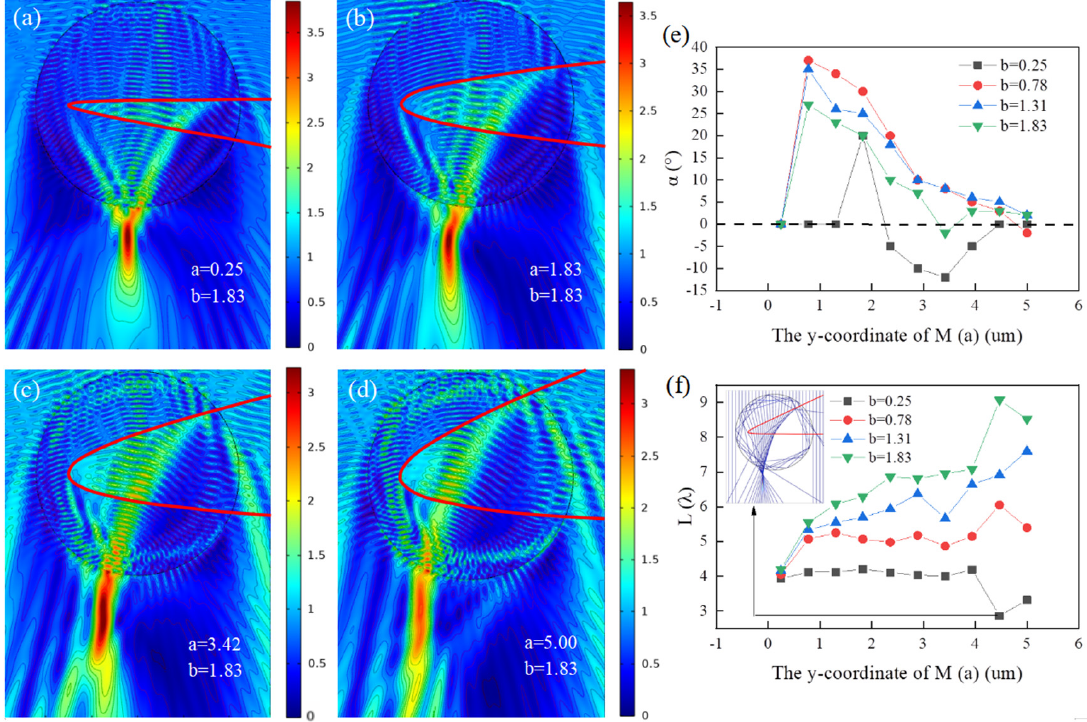
Figure 3. Distribution of electric field under plane wave illumination and the structural property parameters of PH. ( a – d ) P ( − 9.00,0) and N (0, − 1.83). ( a ) M (0,0.25). ( b ) M (0,1.83) and ( c ) M (0,3.42). ( d ) M (0,5.00). ( e ) The changes of the PH bending angle ( α ) with the upward movement of M point from M (0,0.25) to M (0,5.00) under N (0, − 0.25), N (0, − 0.78), N (0, − 1.31), and N (0, − 1.83) for four cases, respectively. ( f ) Relationship between the effective length ( L ) of PH and the upward movement of M point from the same conditions as ( e ). Inset: Ray optical model with M (0,4.47) and N (0, − 0.25).